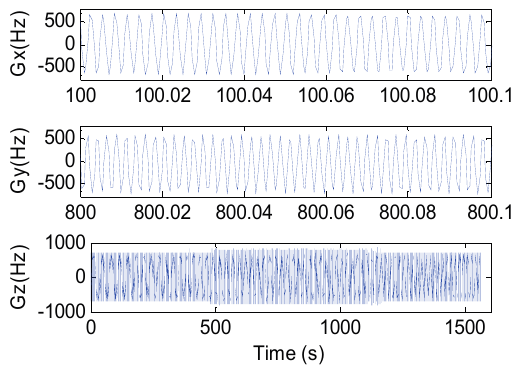
Figure 4. Gyro raw data during three-axis wobbling.